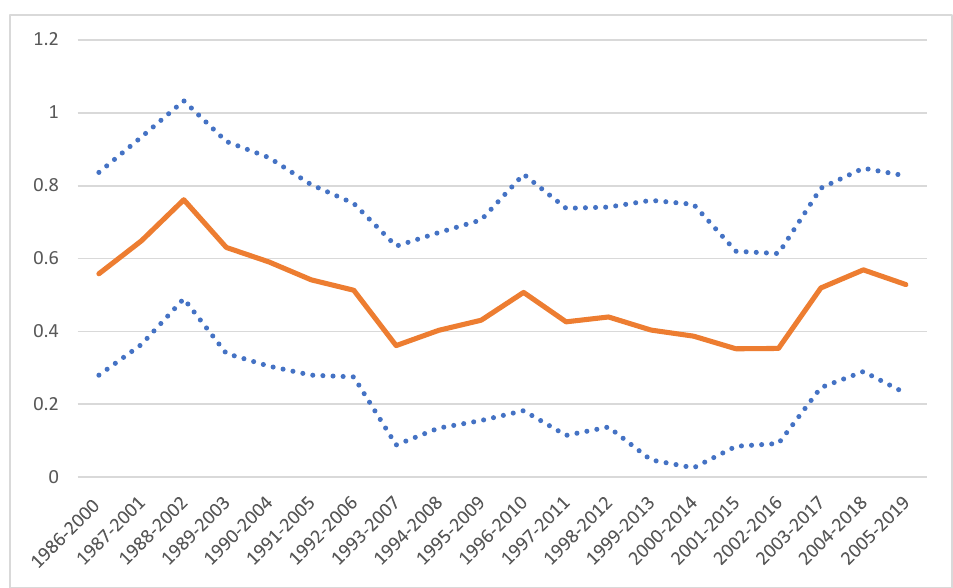
Figure A1. GDP elasticities from rolling window regressions (i.e., Table 3). The solid line is the elasticity estimate. The dashed lines represent the 95% confidence range.